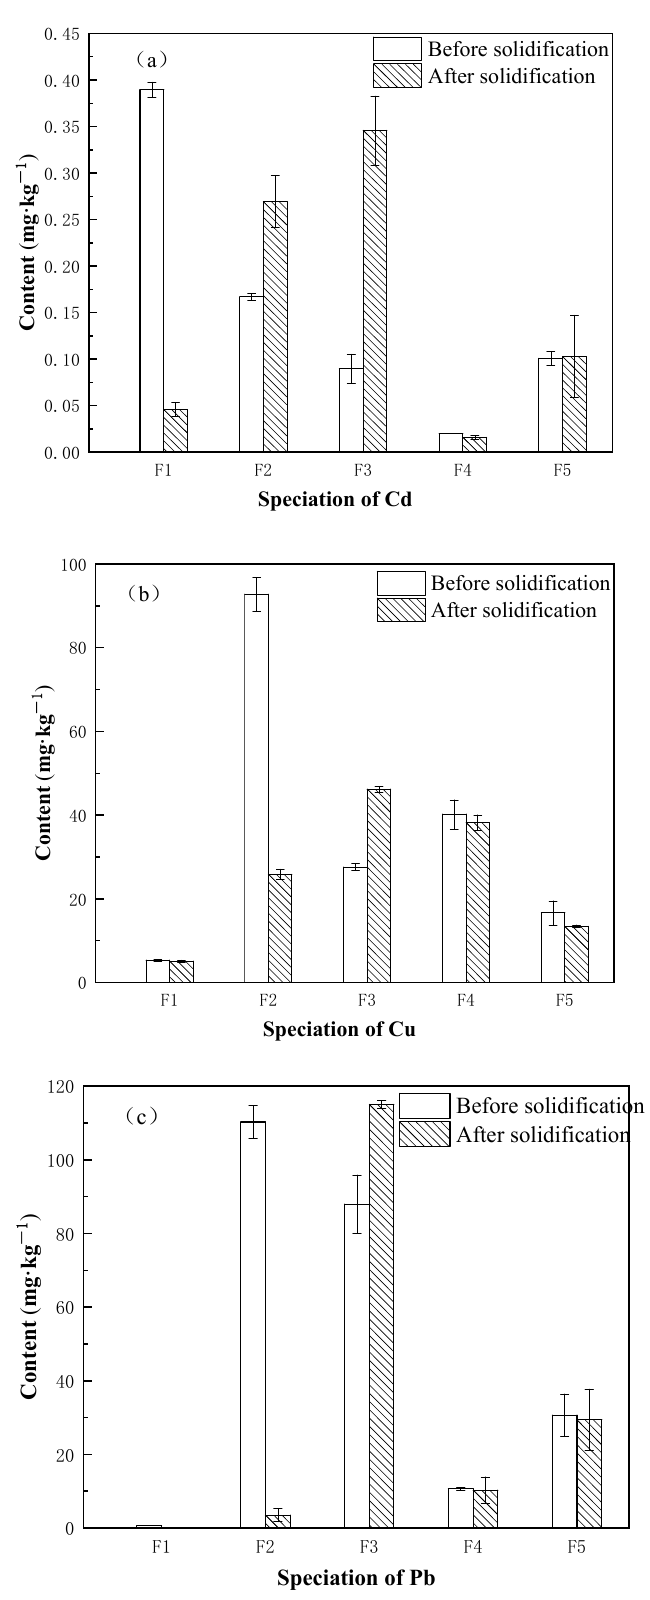
Figure 5. ( a ) Speciation changes of Cd before and after solidification; ( b ) Speciation changes of Cu before and after solidification; and ( c ) Speciation changes of Pb before and after solidification.